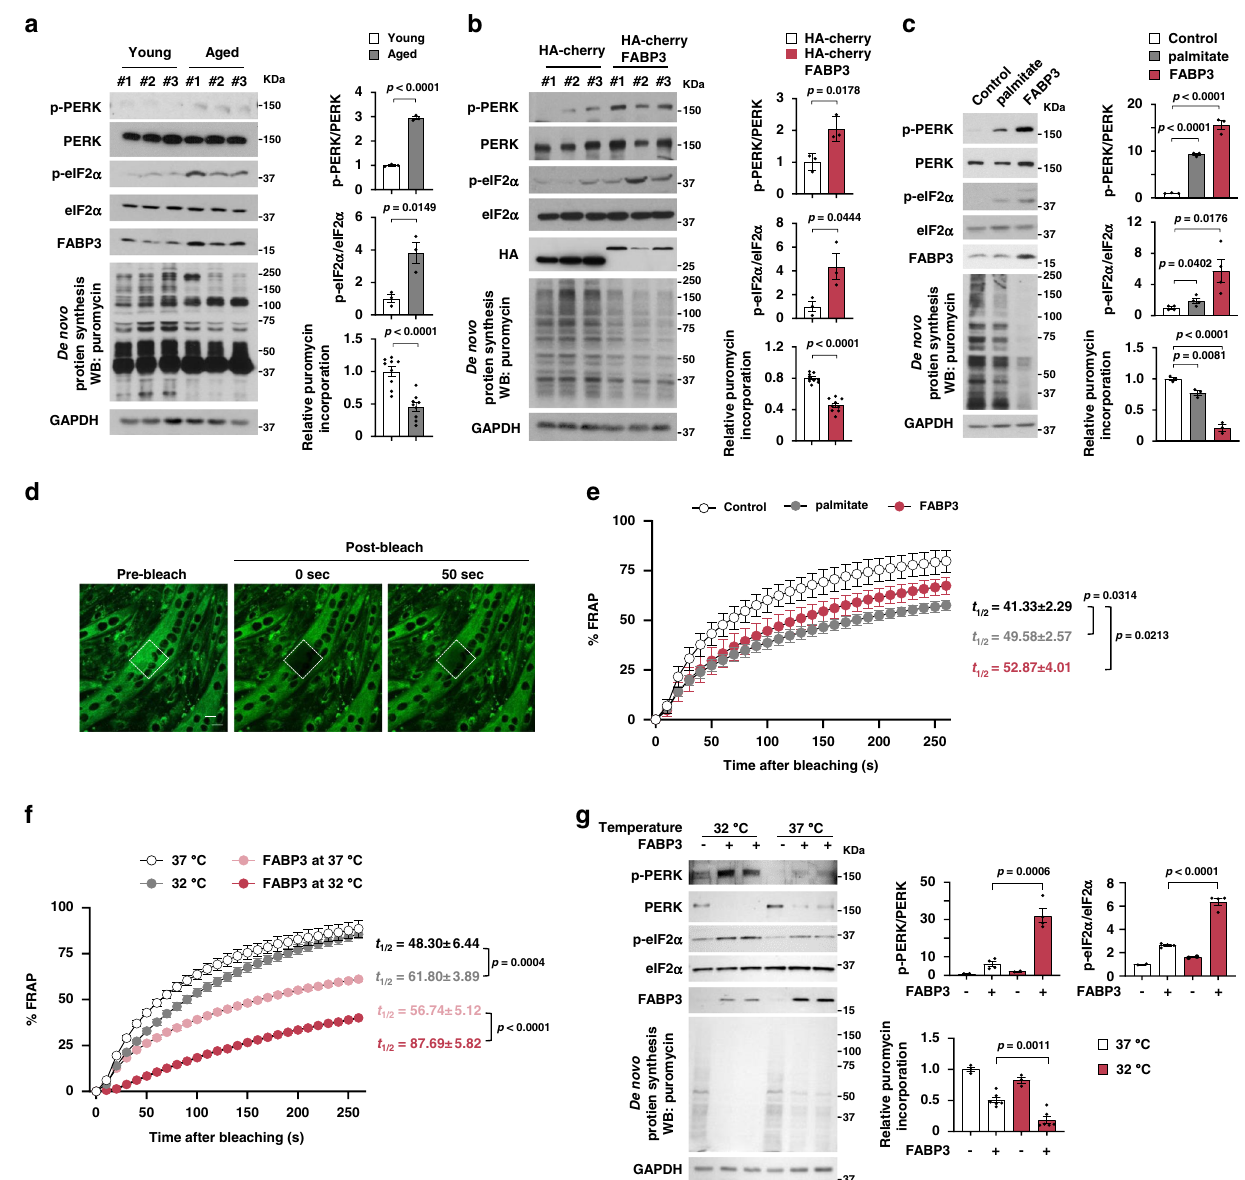
Fig. 3 FABP3-induced membrane rigidity inhibits de novo protein synthesis by inducing the ER stress response. a – c Immunoblot analysis (left) and quanti fi cation (right) of the PERK and eIF2 α phosphorylation and puromycin incorporation in young (6 months) and aged (25 months) TA muscles ( n =